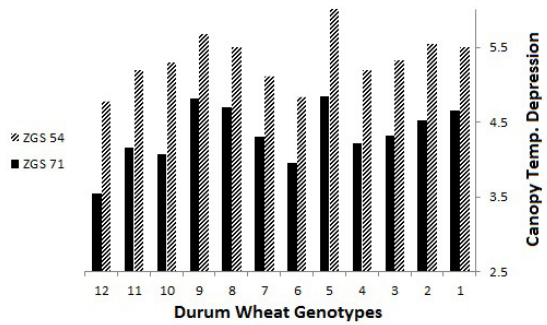
Fig. 4. Canopy temperature depression values of durum wheat genotypes in supplementary irrigation condition